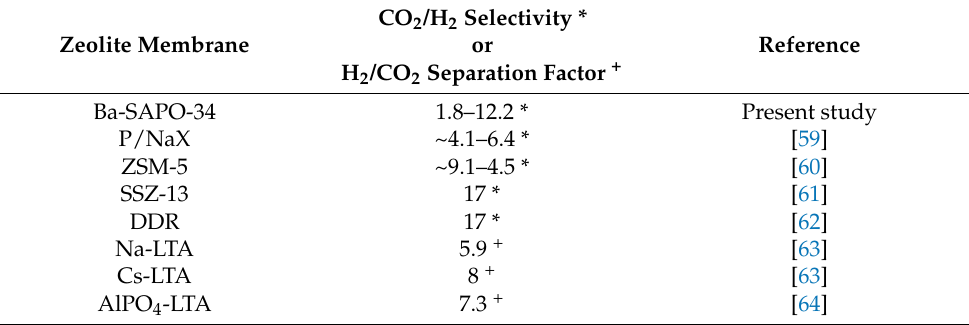
Table 8. Comparison of CO 2 /H 2 separation performance with the other zeolite membranes reported in the